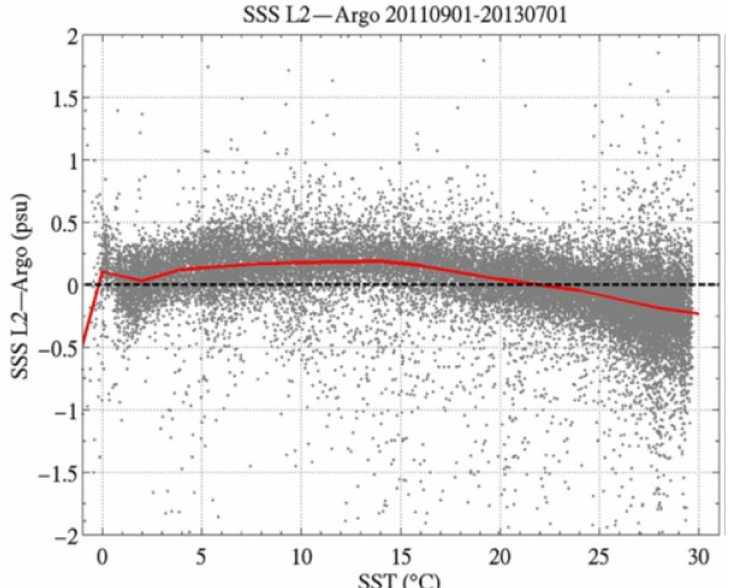
Figure 8. Salinity error (difference between retrieved SSS and in situ salinity from Argo) as a function of sea surface temperature, SST. Grey are the data and red is the median value. (Author’s figure from Le Vine et al.